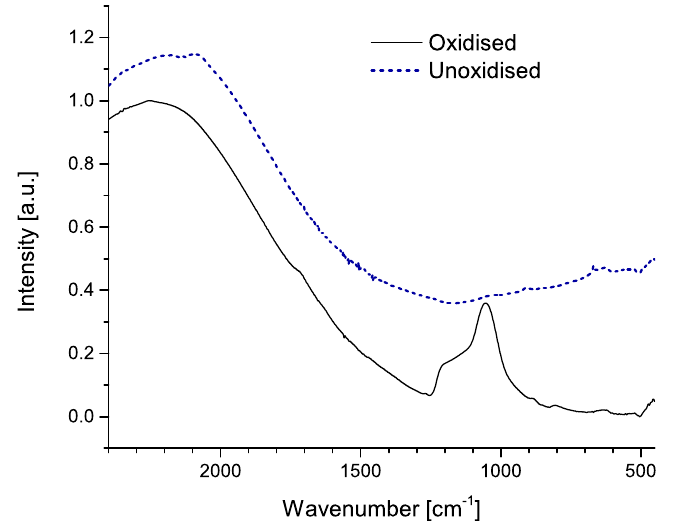
Figure 4. Average FTIR spectrum of thermally oxidized samples (solid black line) and a spectrum of unoxidized sample (dashed blue